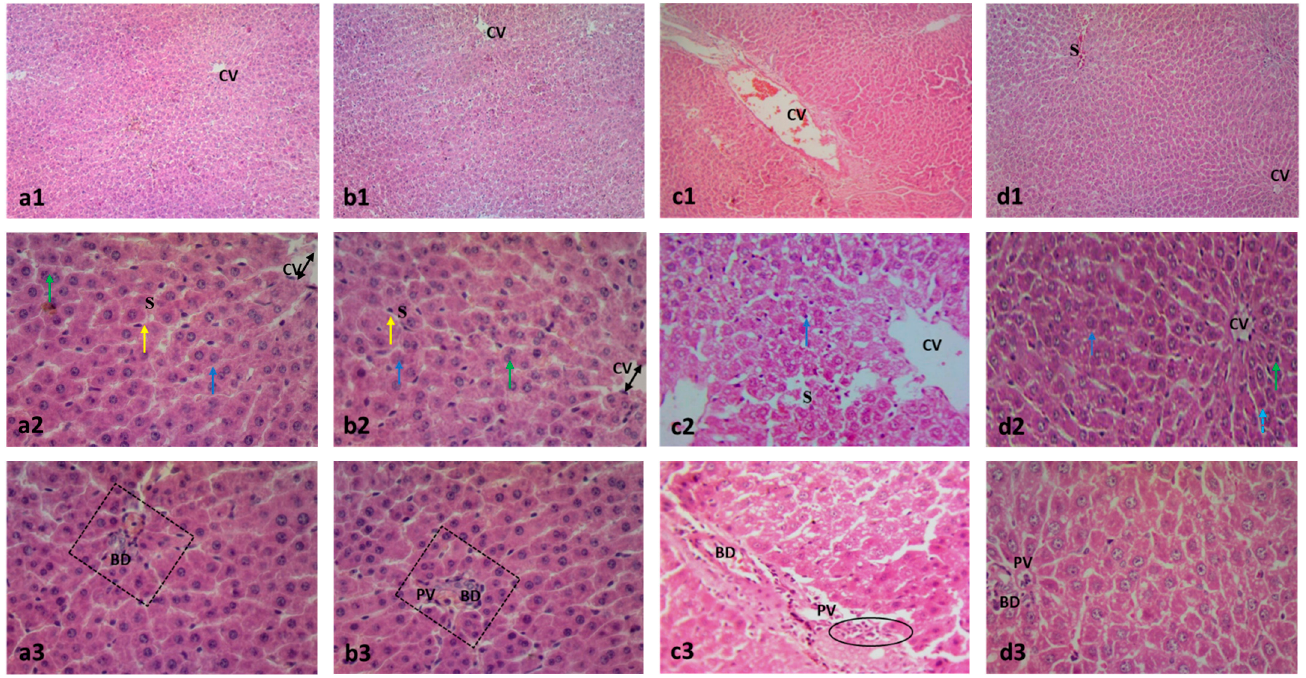
Figure 3. Photomicrographs showing the effect of paeonol on rat liver tissues stained with H&E in methotrexate (MTX)-induced hepatotoxicity (×100 and ×400). The tissue of the control group ( a1 ) showed typical morphological features of hepatic cells with normal lobular architecture and normal central veins (CV). Similarly, the liver tissues of the paeonol group ( b1 ) showed a normal hepatic structure. The liver tissues of both the control and paeonol groups ( a2 , b2 ) showed central veins (CV) which appeared to be lined by flat endothelial cells (double arrows), surrounded by cords of polygonal hepatocytes with granular cytoplasm and central, rounded, vesicular nuclei (blue